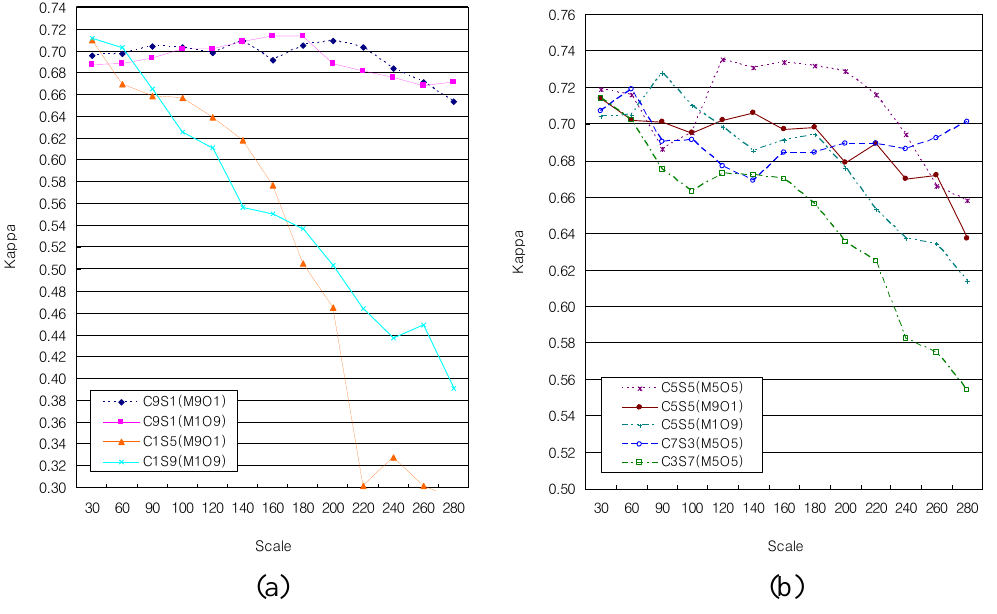
Figure 3. The kappa values of SBCs: (a) strong weights for color or shape, and (b) medium weights for color and